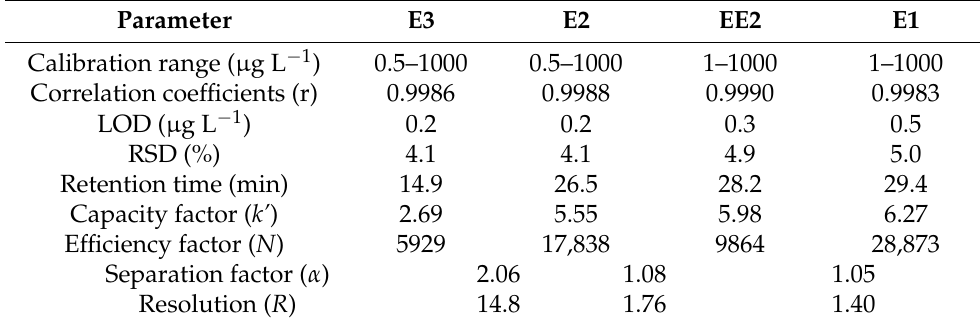
Table 1. Analytical parameters obtained with the proposed method.